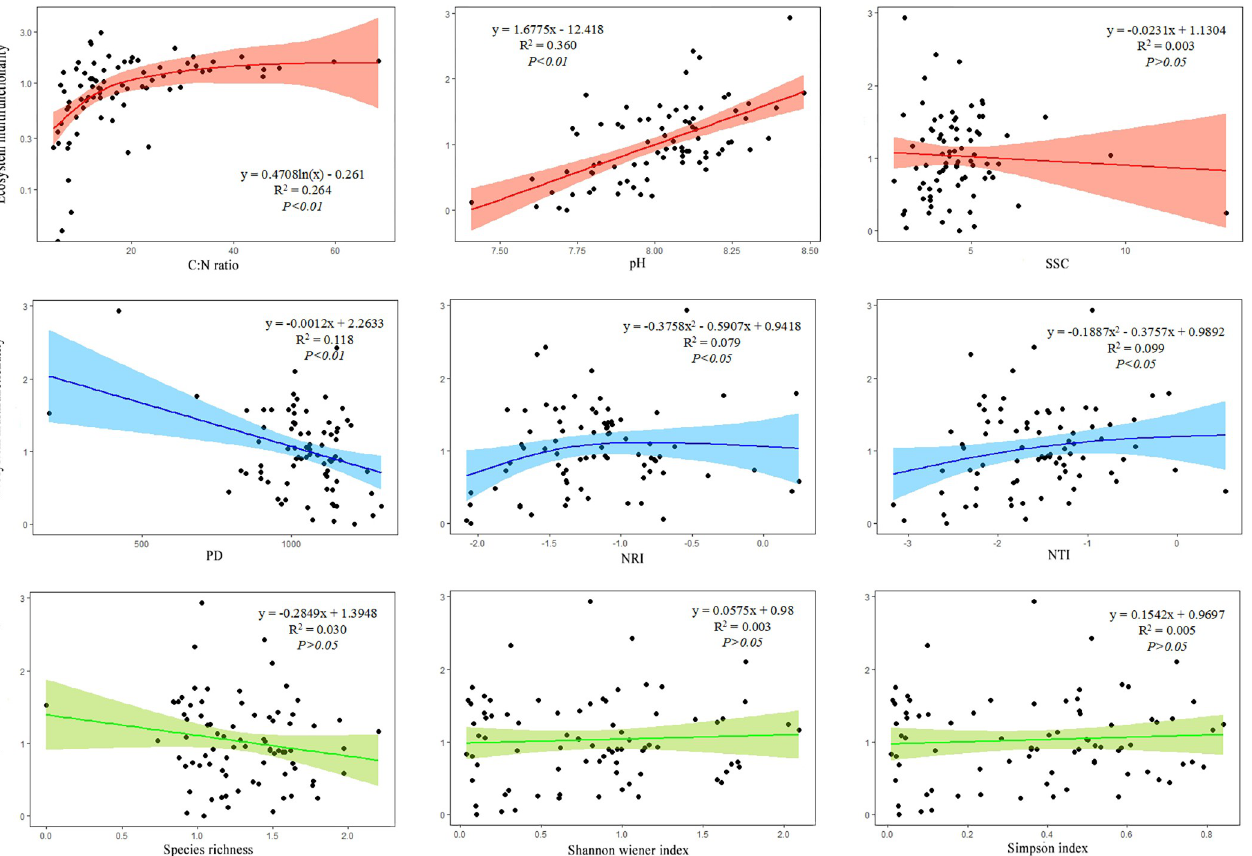
Fig 3. Relationship among plant diversity, abiotic factors, and ecosystem multifunctionality.